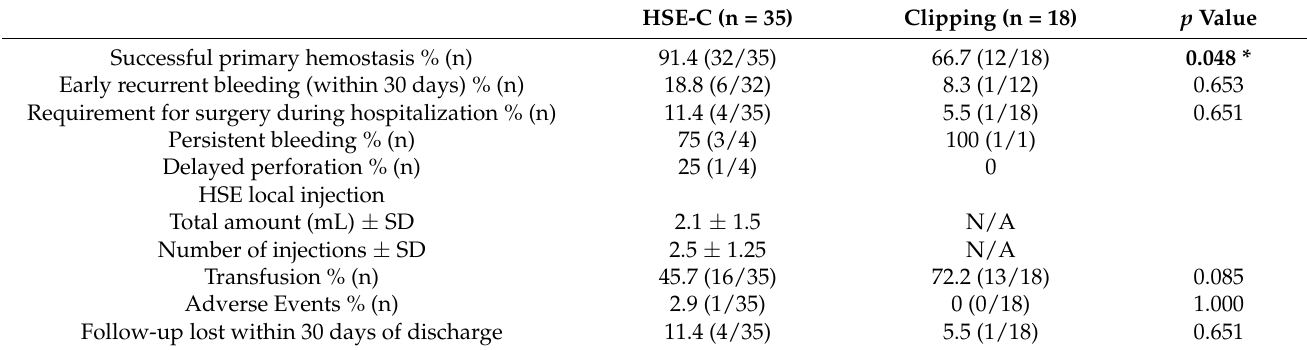
Table 2. Clinical outcomes of patients assigned HSE-C or clipping for active diverticular